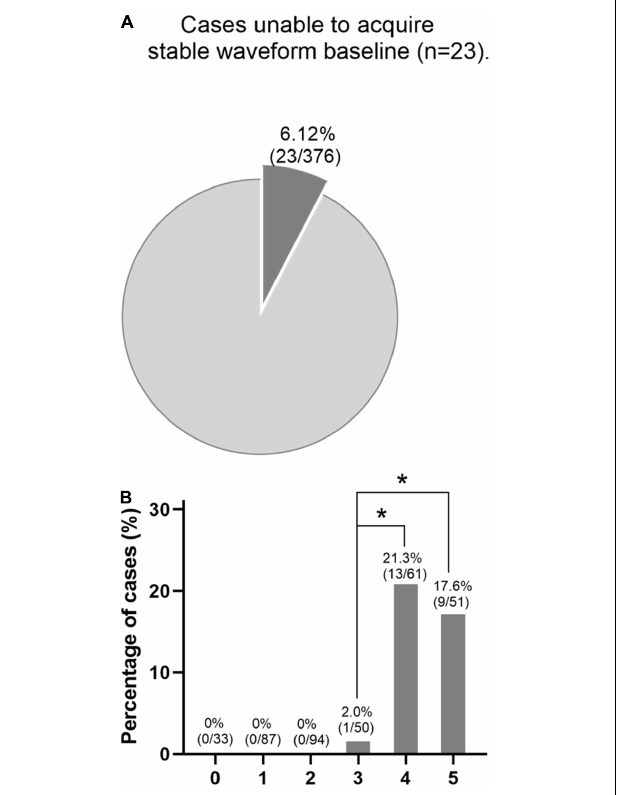
FIGURE 3 | (A) Cases that were unable to acquire stable waveform baseline included 23 patients (6.12%). (B) In this series, the baseline waveforms can be detectable in patients with less than three risk factors. However, the incidence of undetectable baseline waveforms was significantly higher in patients with four or five risk factors compared with patients with three risk factors. * p <